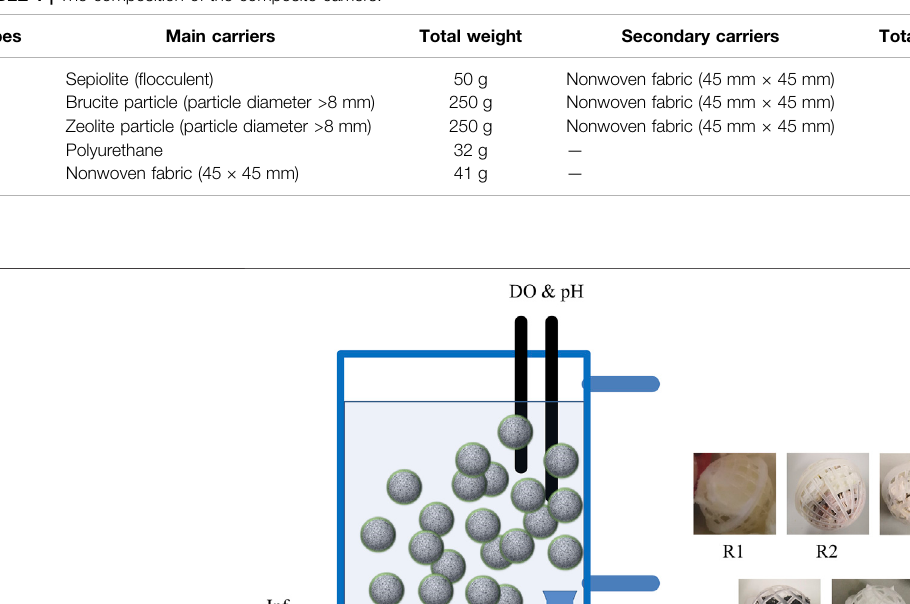
TABLE 1 | The composition of the composite carriers.